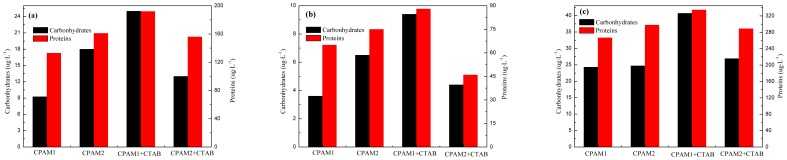
Effects of pH value on EPS at (a) pH = 3, (b) 7, and (c) 11.